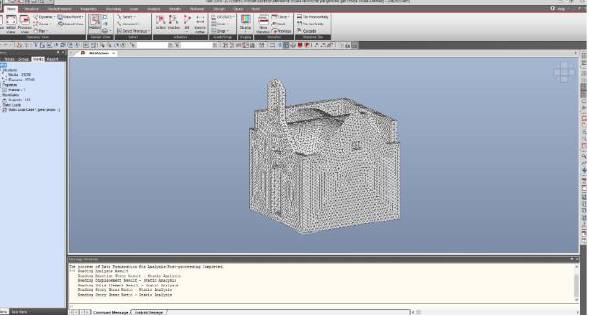
Figure 12. Mesh visualization in calculation software